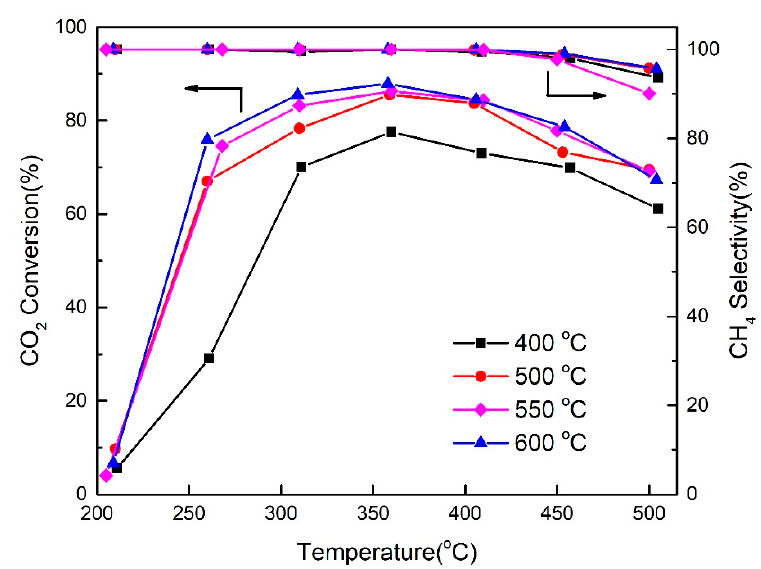
Figure 11. CO 2 conversion (%) and CH 4 selectivity (%) vs temperature profiles for the CO 2 methanation reaction over AMO-Ni 3 Al 1 -CO 3 -LDO reduced in hydrogen at different temperatures, ca. 400, 500, 550 and 600 °C.